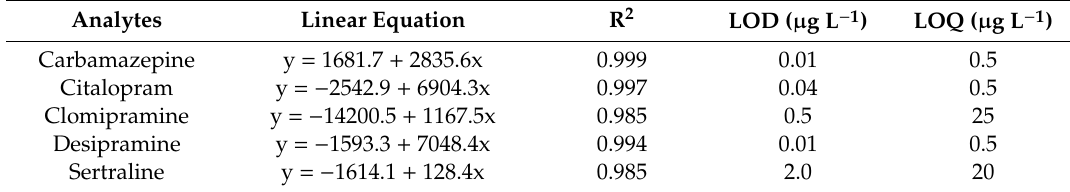
Table 1. Method linearity characteristics and its limits of detection (LOD) and quantification (LOQ).